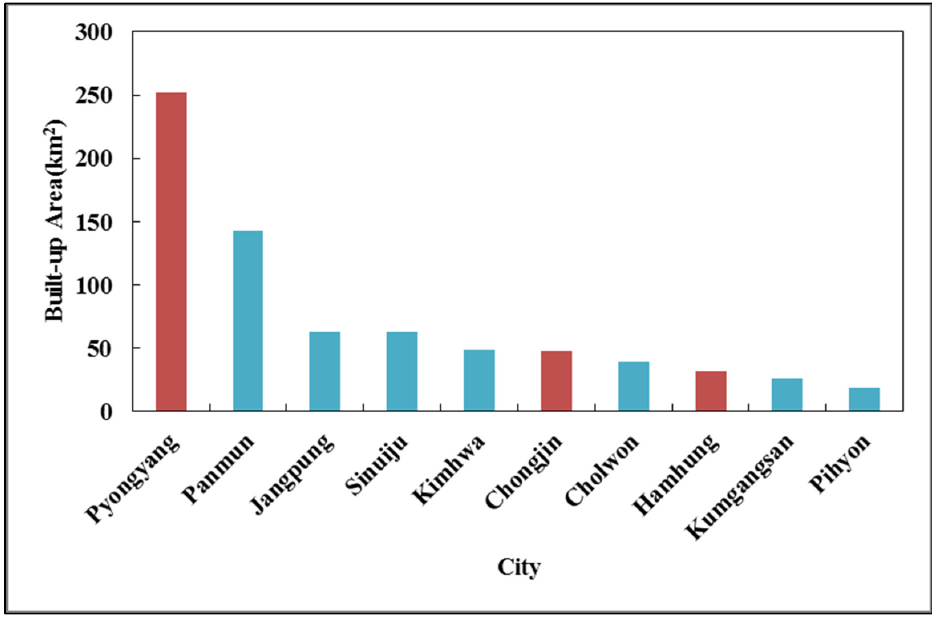
Figure 5. Top ten urban built-up areas in DPRK.